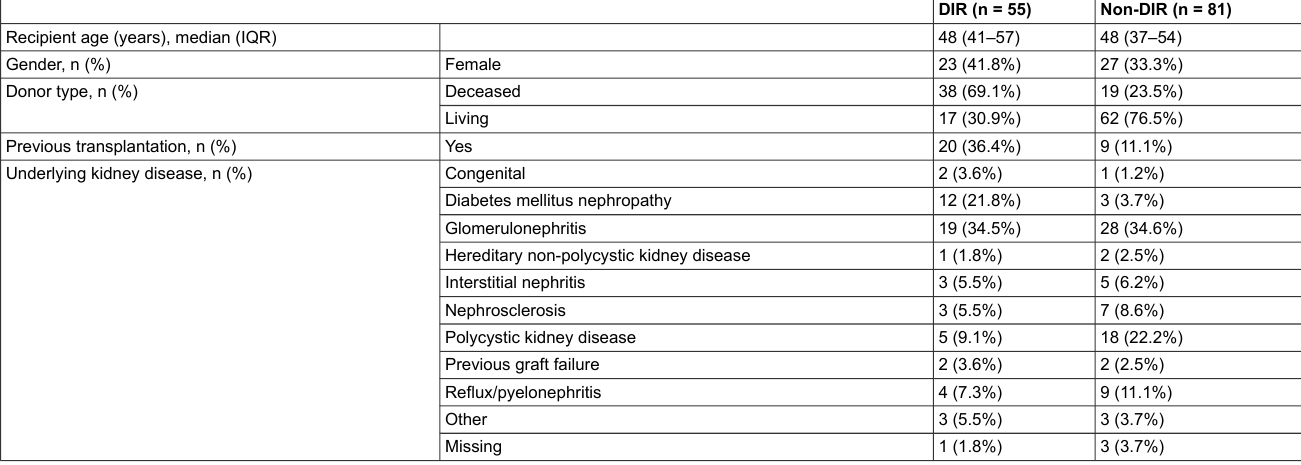
DIR (n = 55) Non-DIR (n = 81)